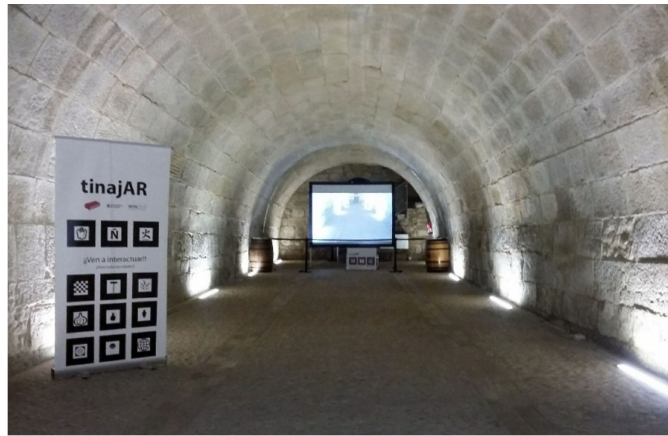
Figure 4. Final setup of the TinajAR system at the Calado de San Gregorio , Logroño, La Rioja,